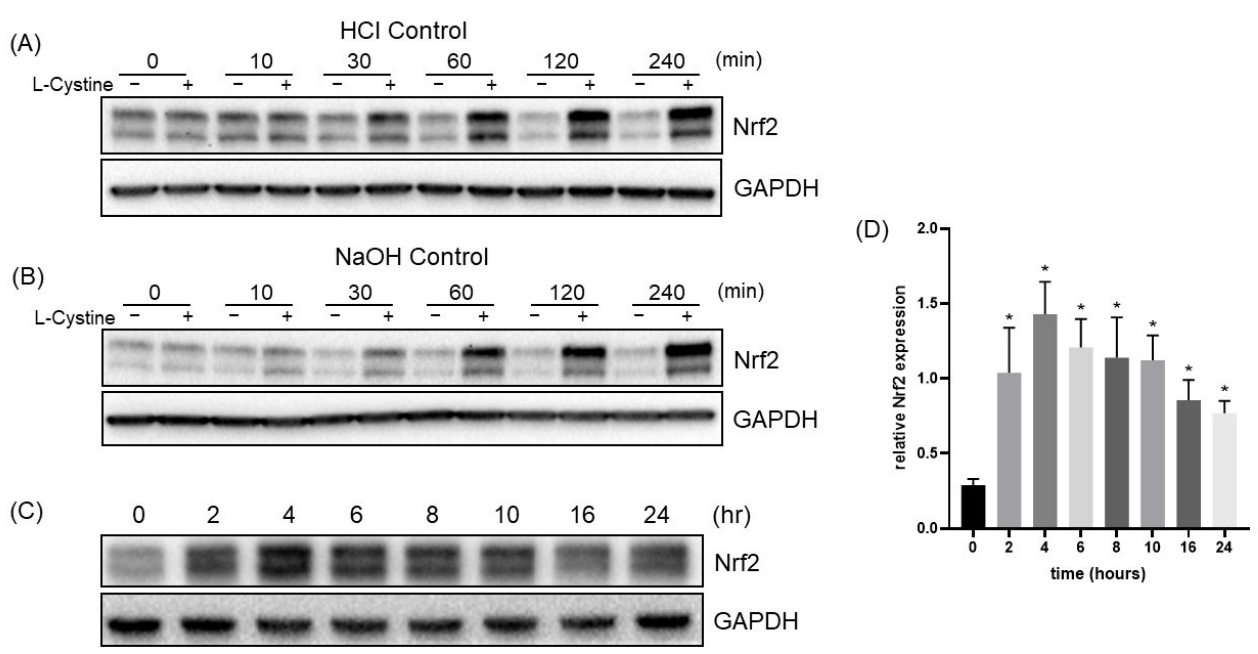
Figure 4. Time-Dependent Nrf2 Protein Induction by L-Cystine. HeLa cells at 3 days after subculture was treated with 0.8 mM L-Cystine from its stock dissolved in 500 mM HCL ( A , C , D ) or 200 mM NaOH ( B ) for indicated time points. An equal volume of solvents was added to the cells in the control groups. The cells were harvested at the end of the time point for Western Blot to detect the level of Nrf2 protein, using GAPDH as a loading control. The band intensities were quantified by NIH ImageJ to be presented as means ± SD of Nrf2/GAPDH ratio from three independent experiments ( D ). * indicates statistically significant compared to the 0-h time point as the adjusted p value < 0.05 by one-way ANOVA, corrected by Dunnett’s multiple comparisons test ( D ).